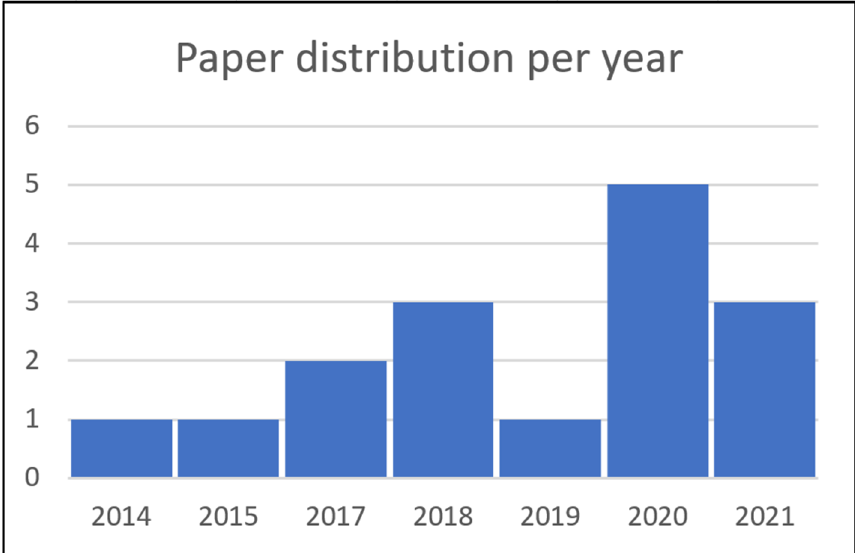
Figure 2. Distribution of the selected publications per year.